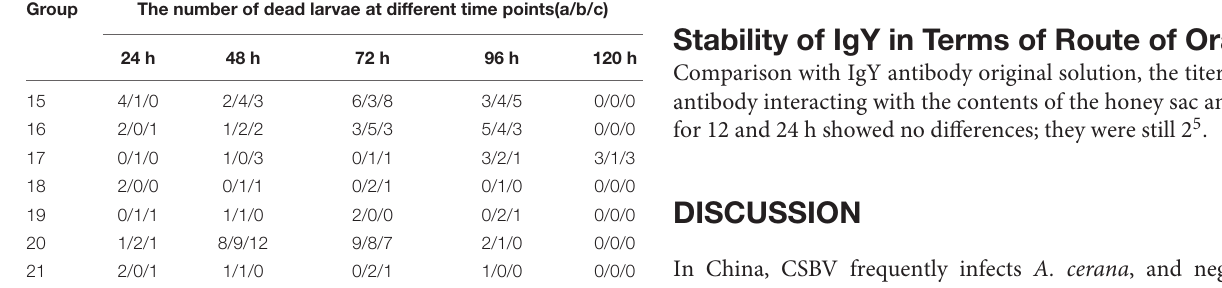
TABLE 3 | The preventative effect on CSBV of using the specific IgY.